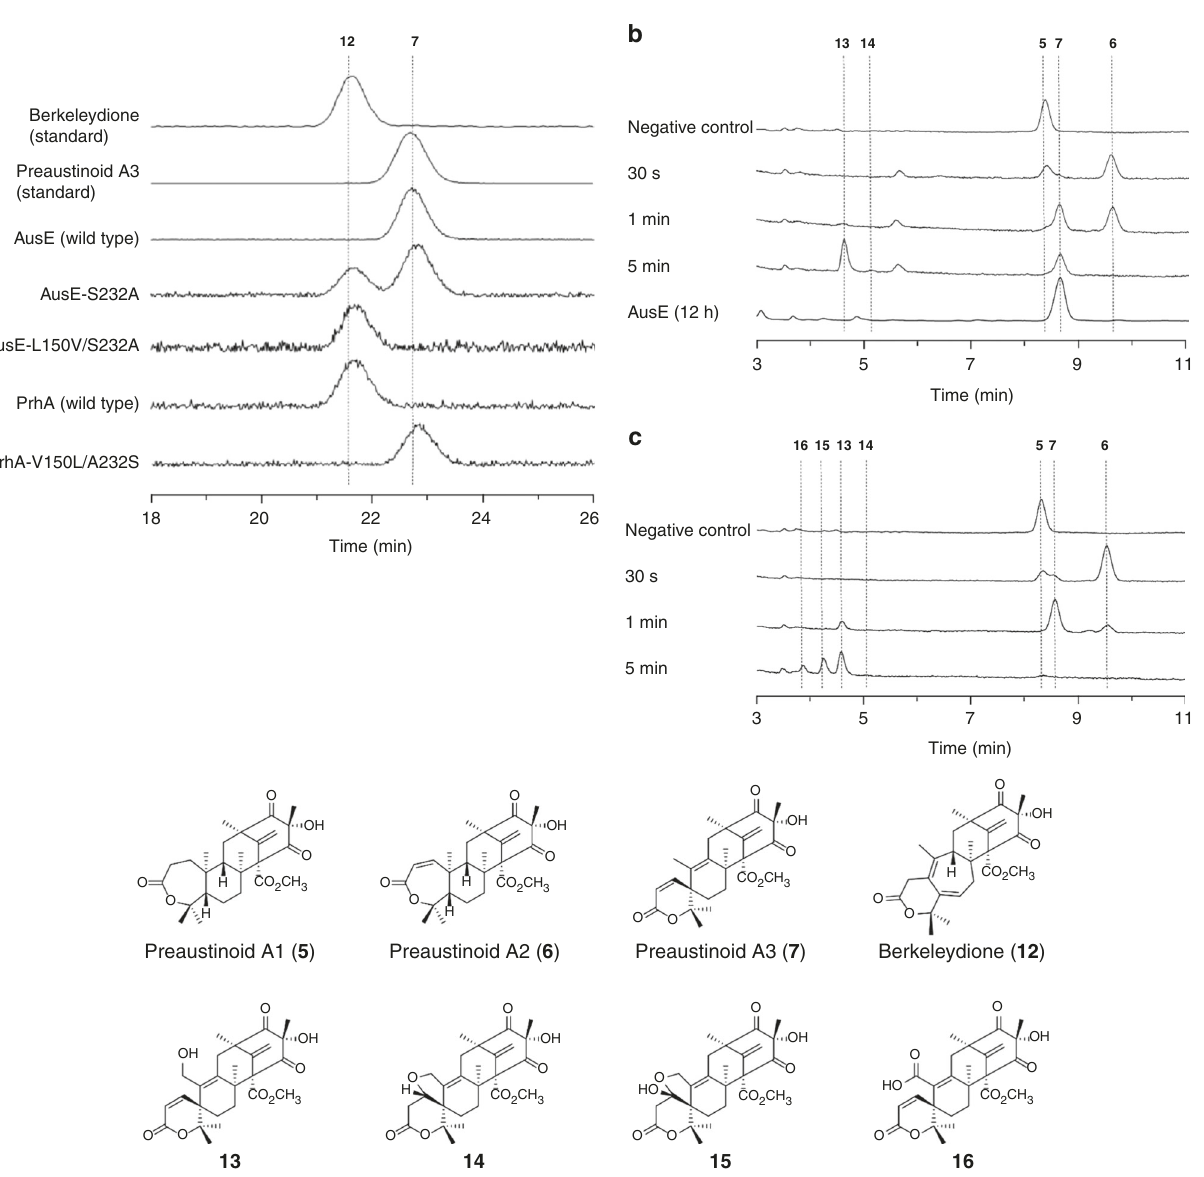
Fig. 3 In vitro enzyme reactions of the wild-type and mutant AusE and PrhA with preaustinoid A1 ( 5 ). a LC-MS extracted ion chromatograms of 12 and 7 ( m/z 457.2) in the in vitro enzymatic reactions of 5 and wild-type AusE, AusE-L150V, AusE-L150V/S232A, wild-type PrhA, or PrhA-V150L/A232S. All of the reactions were performed for 5 min. b , c HPLC chromatograms of in vitro enzymatic reactions of 5 and PrhA-V150L/A232S ( b ) or PrhA-V150L/ A232S/V241M ( c ), respectively. The reactions of PrhA-V150L/A232S and PrhA-V150L/A232S/M241V were performed for 30 s, 1 and 5 min. The reaction of wild-type AusE was performed for 12 h as a reference ( b ). New peaks corresponding to 13 – 16 were only observed in the reaction of PrhA-V150L/A232S and PrhA-V150L/A232S/M241V, and not in the reaction of wild-type AusE. HPLC condition optimized for separation of 13 – 16 was used for analysis. 5 incubated in pH 7.5 PIPES buffer for 12 h in the absence of enzyme was used as a negative control. Chromatograms were monitored at 223